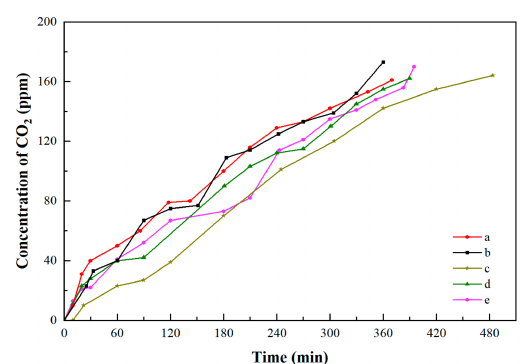
Figure 9. Comparison of breakthrough curves of Zn(NO 3 ) 2 -13X at 20 ◦ C for different activation temperatures: (a) 350 ◦ C, (b) 400 ◦ C, (c) 450 ◦ C, (d) 500 ◦ C and (e) 550 ◦ C,